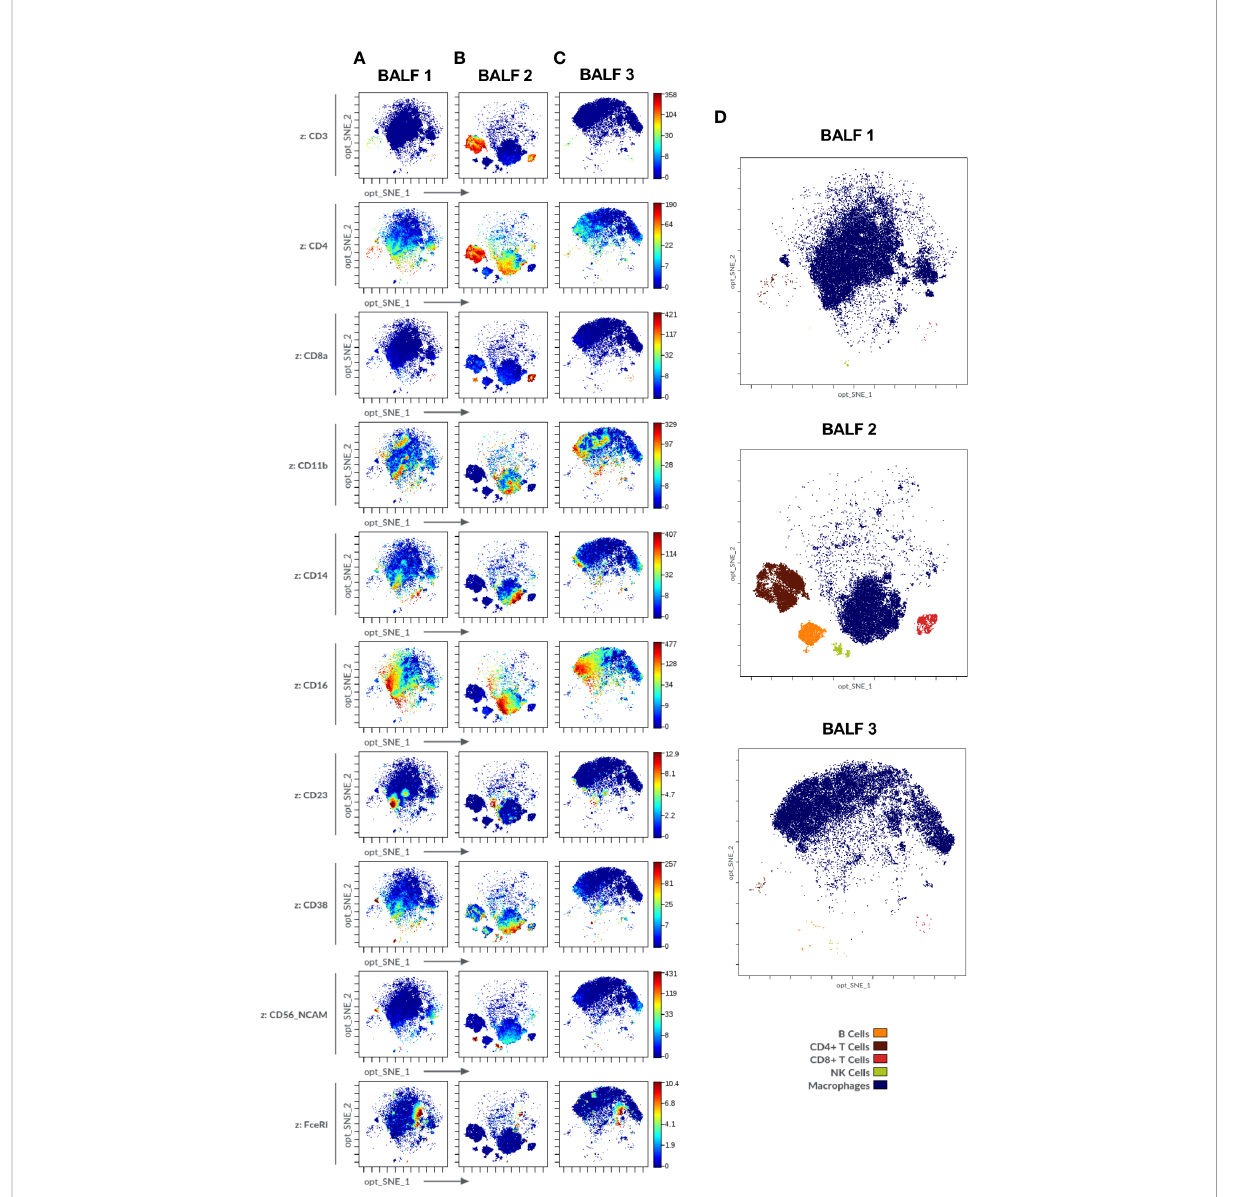
FIGURE 6 Immune cell markers in human bronchoalveolar lavage fl uid (BALF) of diverse patients acquired in Helios ® (Standard BioTools). (A-C) Opt-SNE plots show selected markers of the modi fi ed Maxpar Direct Immune Pro fi ling Assay (MMDIPA panel) namely CD3, CD4, CD8a, CD11b, CD14, CD16, CD23, CD38, CD56, and Fc ϵ RI. BALFs from patients with (A) non-small cell lung carcinoma (BALF 1), (B) previous COVID-19 infection (BALF 2) and (C) asthma (BALF 3) are shown. Plots shown are representative of three independent experiments. (D) Identi fi cation of immune cell populations in the three BALF using mass cytometry. Opt-SNE show manually selected cell populations: B Cells, CD4+ T Cells, CD8+ T Cells, Natural Killer (NK) Cells, Macrophages. The manually annotated populations in (C) and (D) are overlaid as a